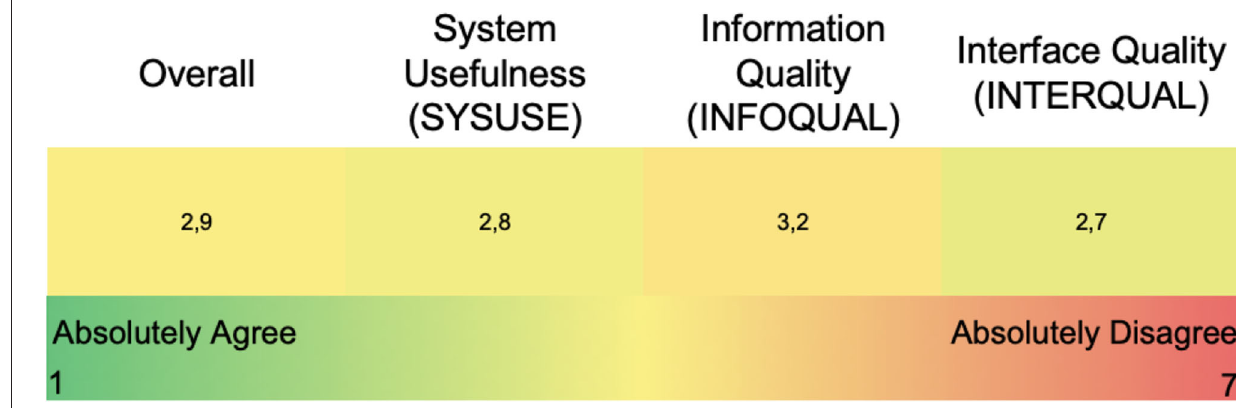
FIGURE 6 | PSSUQ scores for the HCP web application (overall and sub-scores).